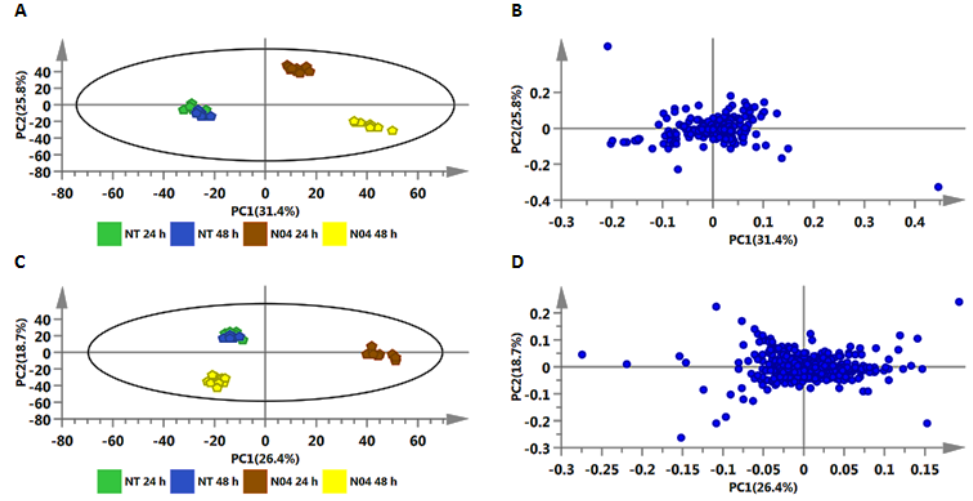
Figure 2. The principal component analysis (PCA) scores and loadings plots of metabolites extracted from tomato plant stems treated with Pseudomonas fluorescens N04. The PCA scores scatter plots ( A and C ) show clear separation and grouping of control and treated samples, respectively. The PCA loadings plots ( B and D ) show ions contributing to the clustering. The X-axis and Y-axis describe the first and second principle components (PCs), respectively. ( A and B ) = ESI negative data and ( C and D ) = ESI positive data.